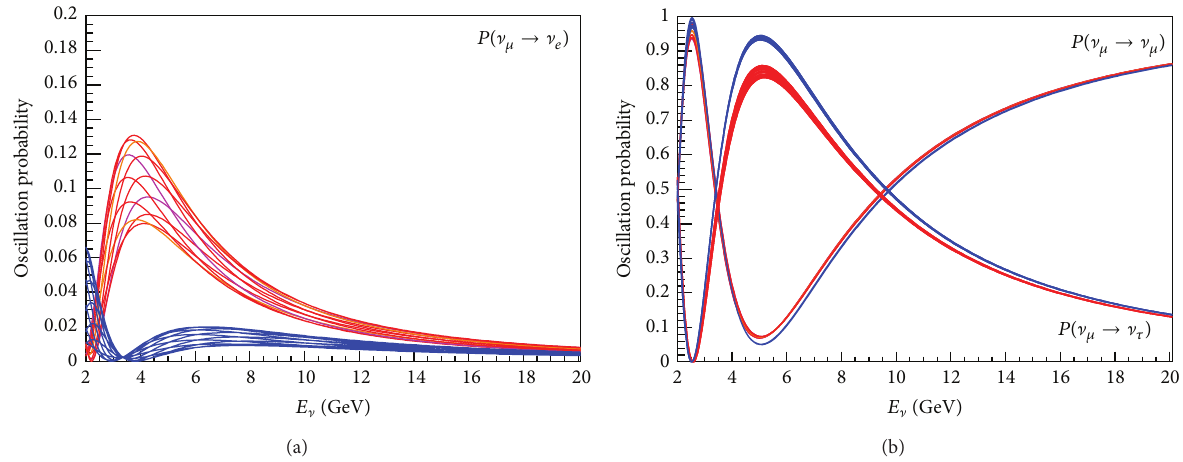
Figure 12: Neutrino oscillation probabilities 𝑃( ] 𝜇 → ] 𝑒 ) , 𝑃( ] 𝜇 → ] 𝜇 ) and 𝑃( ] 𝜇 → ] 𝜏 ) for a baseline of 2600 km and oscillation parameters from a global fit as a function of neutrino energy. The group of red lines is for NH, blue for IH and 𝜙 = 0 ∘ ,180 ∘ (CP conservation) are indicated in magenta, 𝜙 330 ∘ . The special values 𝜙 CP left plot.